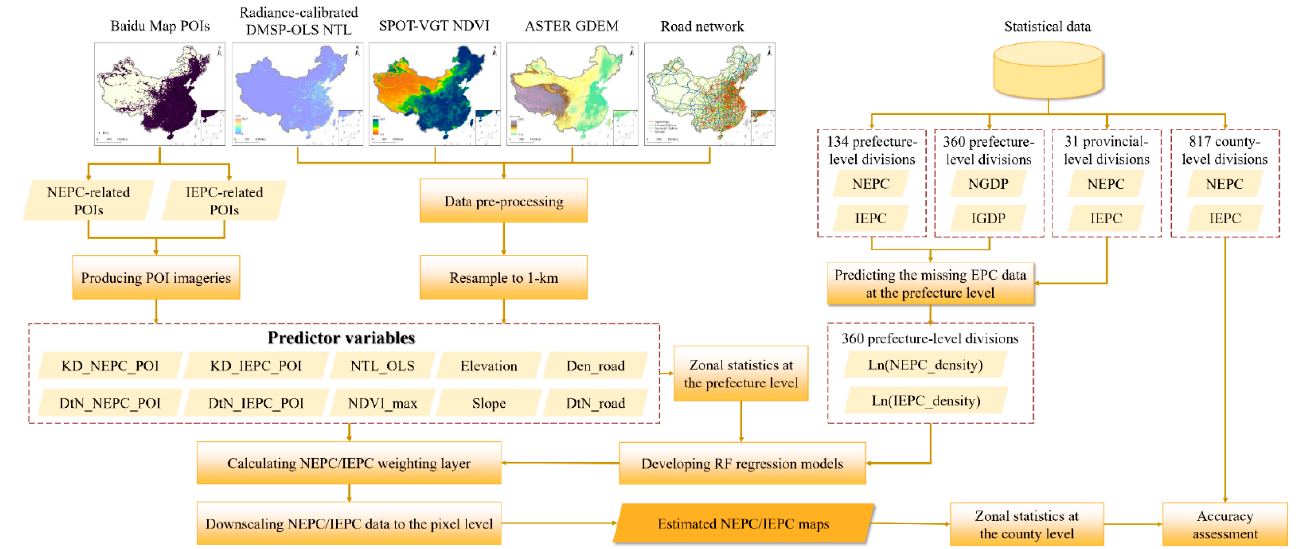
Figure 1. Flowchart of the proposed methodology for electric power consumption (EPC) estimation.